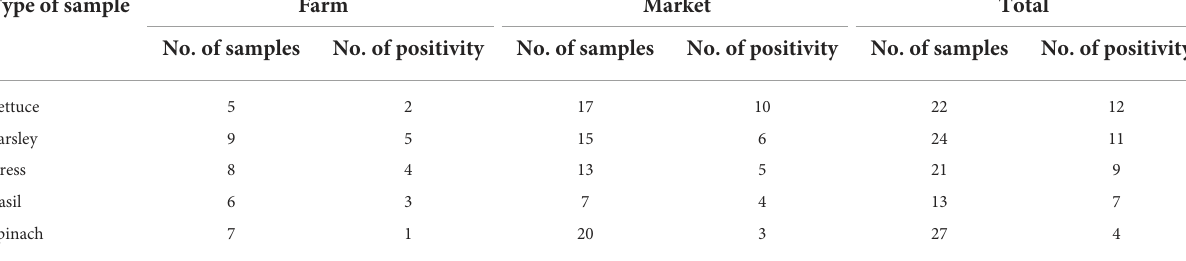
TABLE 4 Prevalence of SARS-CoV-2 RNA in different type of vegetable samples that was selected from farms and markets. Type of sample